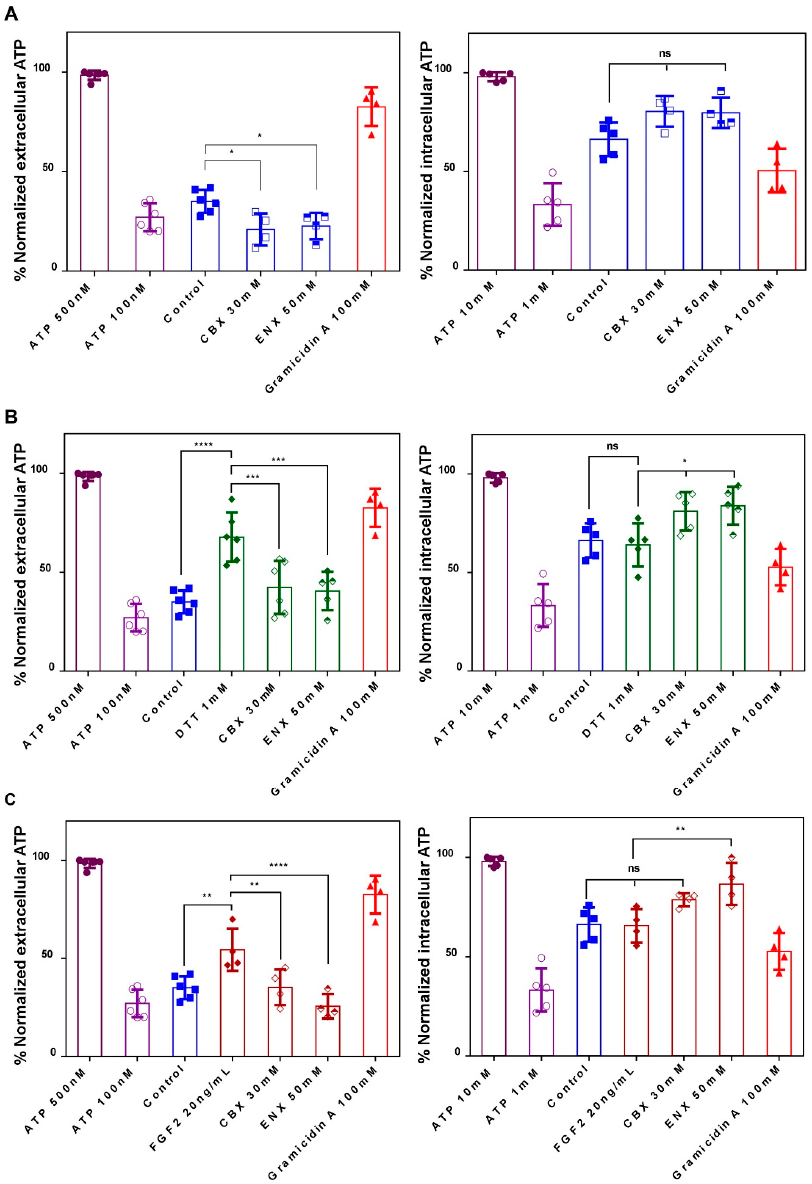
Figure 4. ATP Release during neurulation is regulated by HCs-Cxs modulators. Using luminescence assays ( A ), extracellular and intracellular ATP (nM) were quantified and normalized to the calibration curve. ( B ). Embryos treated with redox potentials. ( C ). Embryos treated with mitogenic factors. The results correspond to at least four experiments conducted independently (N = 4), for each condition. One-way ANOVA, Bonferroní comparison test, (* = p < 0.05; ** = p < 0.01; *** = p < 0.001; **** = p < 0.0001; ns = not significant.). The error bars for the data represent the standard deviation.